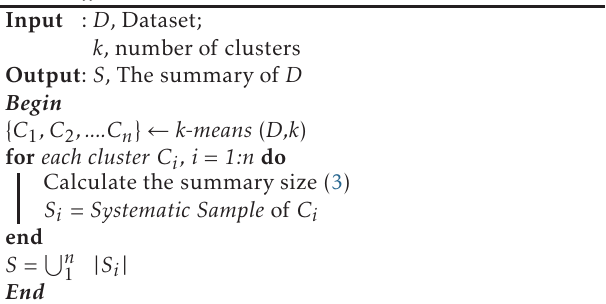
ALGORITHM 1: RCNTS(Regular Clustering based Net-